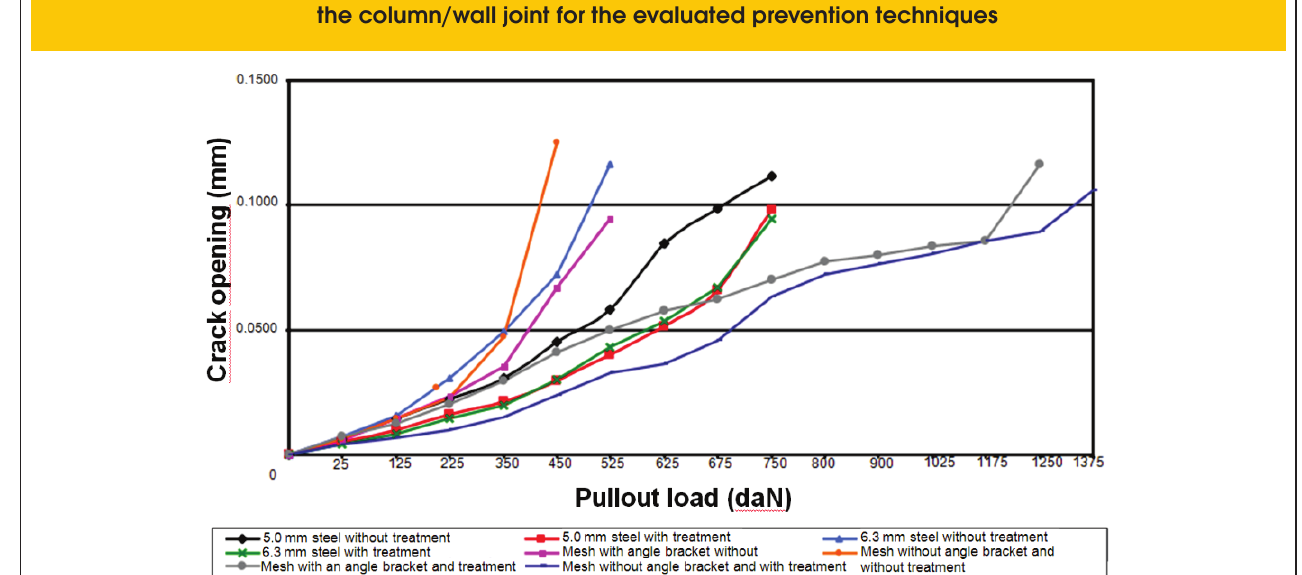
Figure 11 – Results of the evolution of the opening of the crack in the column/wall joint for the evaluated prevention